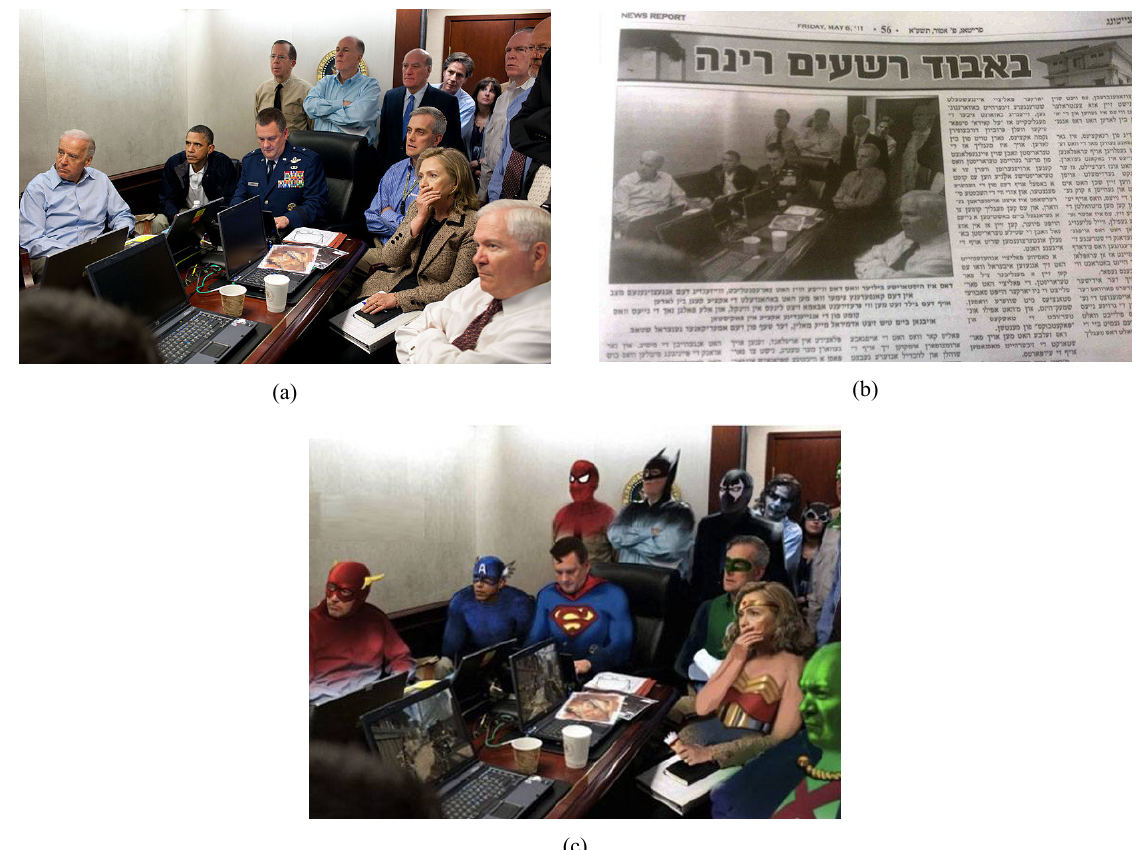
Figure 8 - “The Situation Room” photo. ( a ) Source image taken by the White House photographer Pete Souza; ( b ) A version produced by the Brooklyn-based Hasidic newspaper removing Secretary of State Hillary Clinton and another woman from the photo. Source: (HUFFPOST 2011); and ( c ) A meme depicting the politicians as super heroes. Source: (ENews